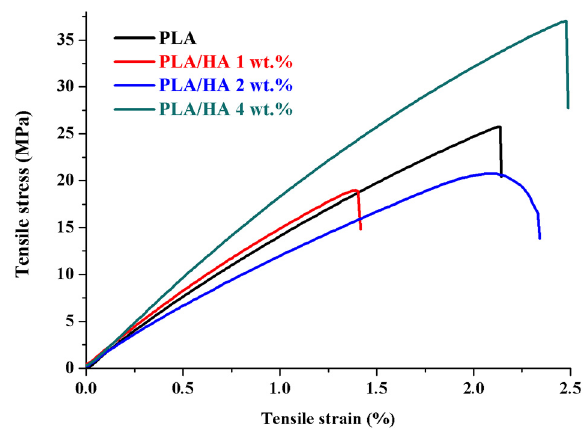
Table 2. Mechanical tests of obtained materials.